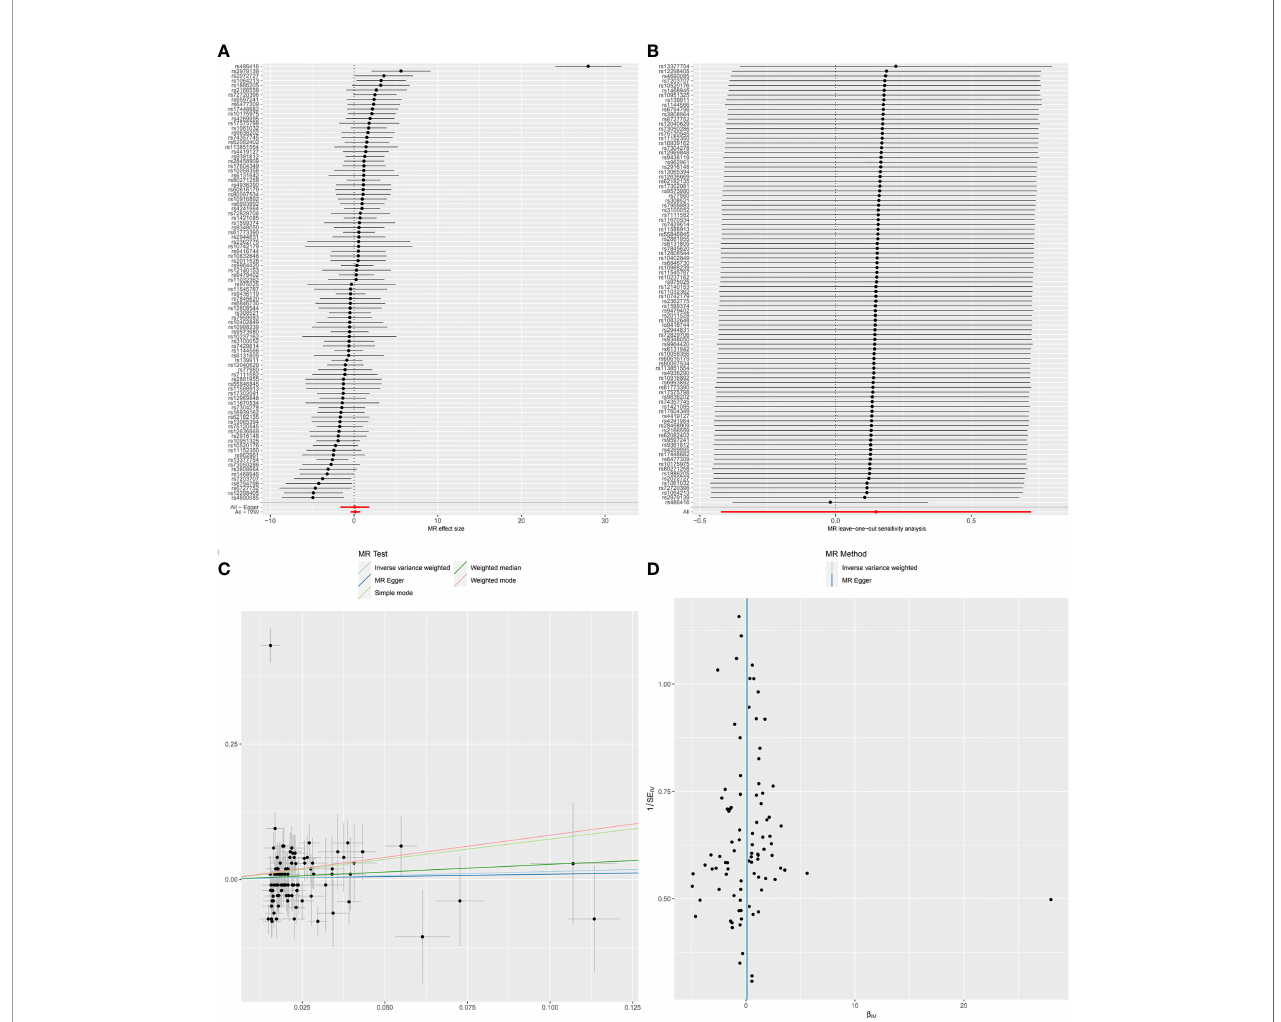
FIGURE 1 | Forest plot (A) , sensitivity analysis (B) , scatter plot (C) and funnel plot (D) of the causal effect of Chronotype on SLE